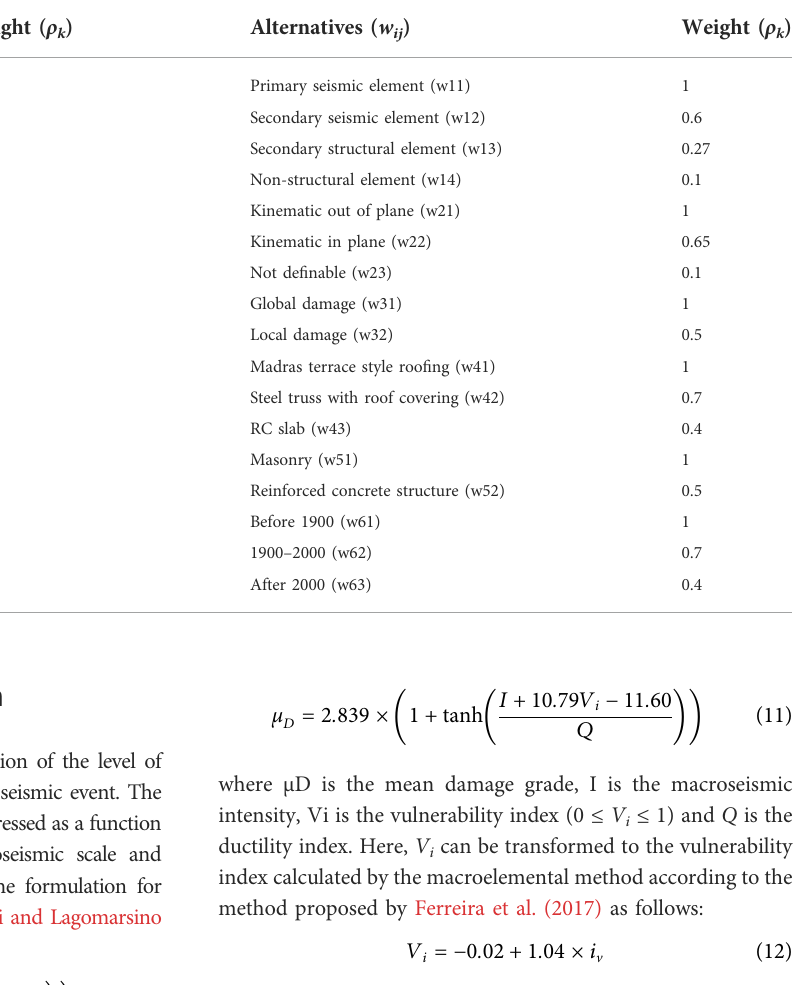
TABLE 4 Weights of selected criteria and